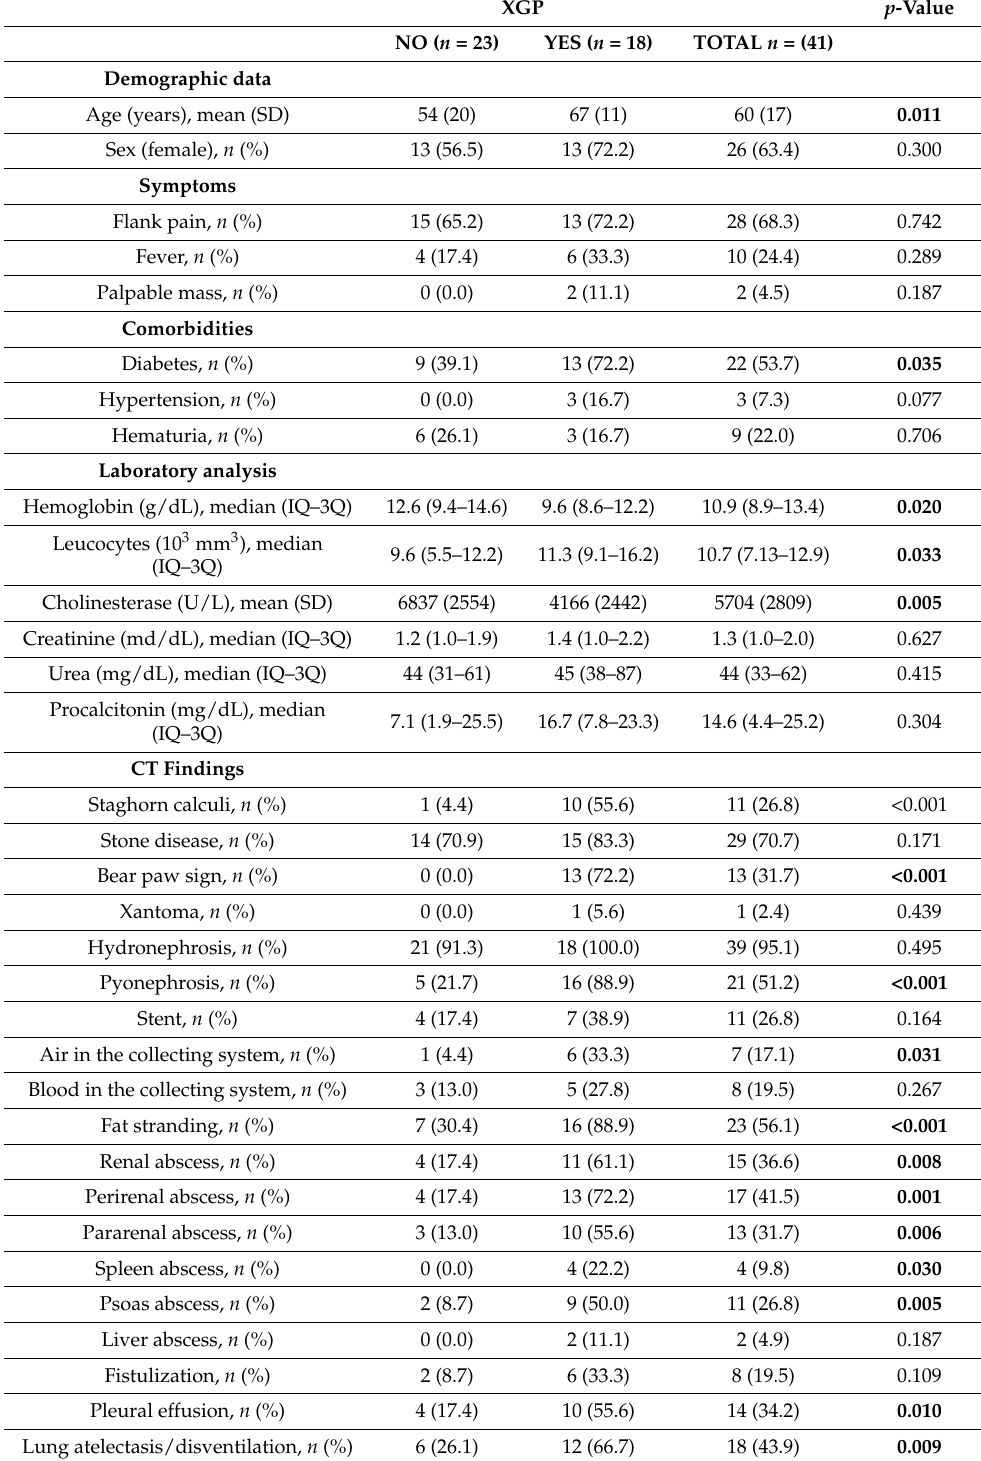
Table 1. Descriptive analysis of XGP among all